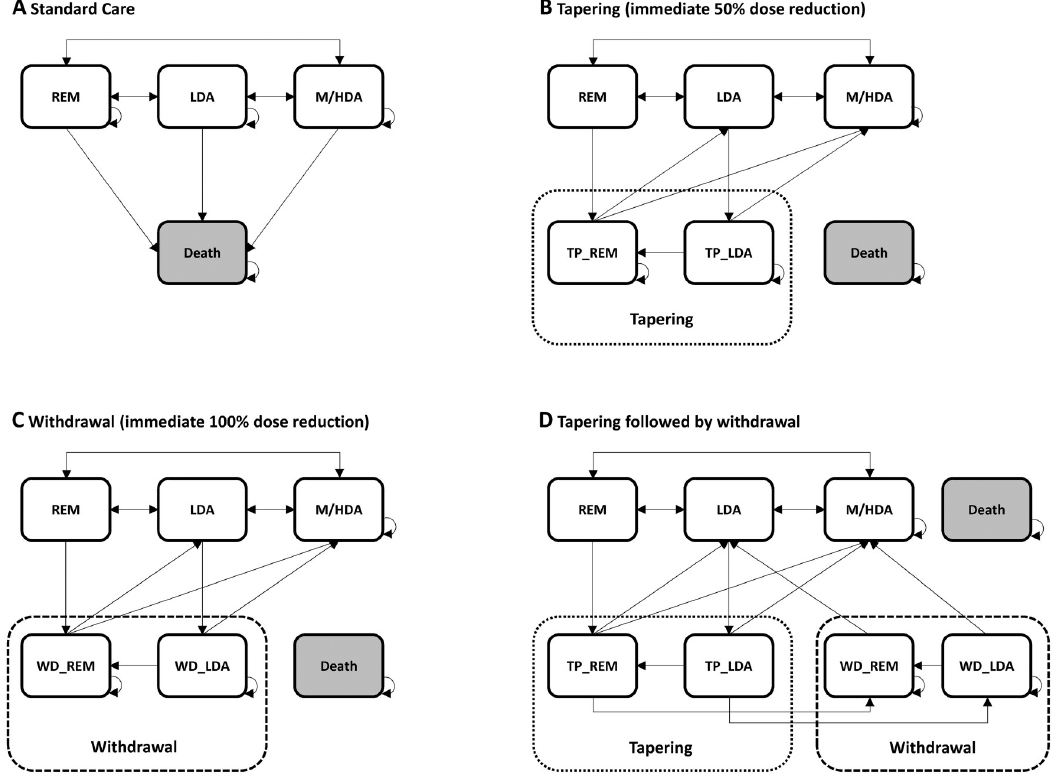
Fig 1. Model structure. (A) standard care without dose adjustments, (B) tapering, (C) withdrawal, (D) tapering followed by withdrawal of bDMARDs. REM: remission, LDA: low disease activity, M/HDA: medium to high disease activity, TP_REM: remission under tapering, TP_LDA: low disease activity under tapering, WD_REM: remission under immediate withdrawal, WD_LDA: low disease activity under immediate withdrawal. Arrows indicate possible transitions between states at each model cycle of 6